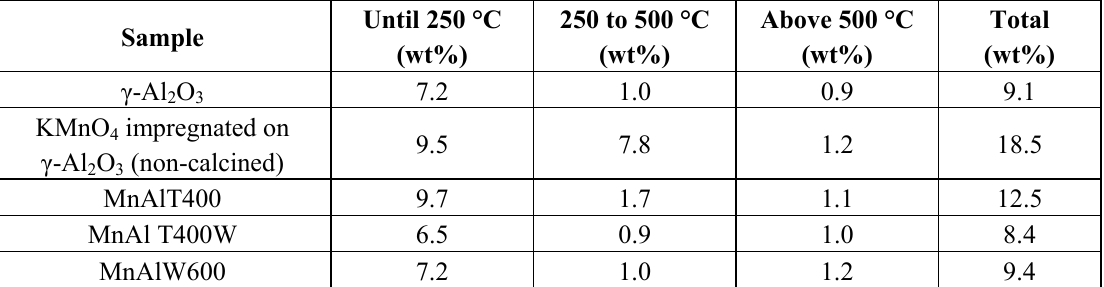
Table 2. Weight loss in TGA experiments in N